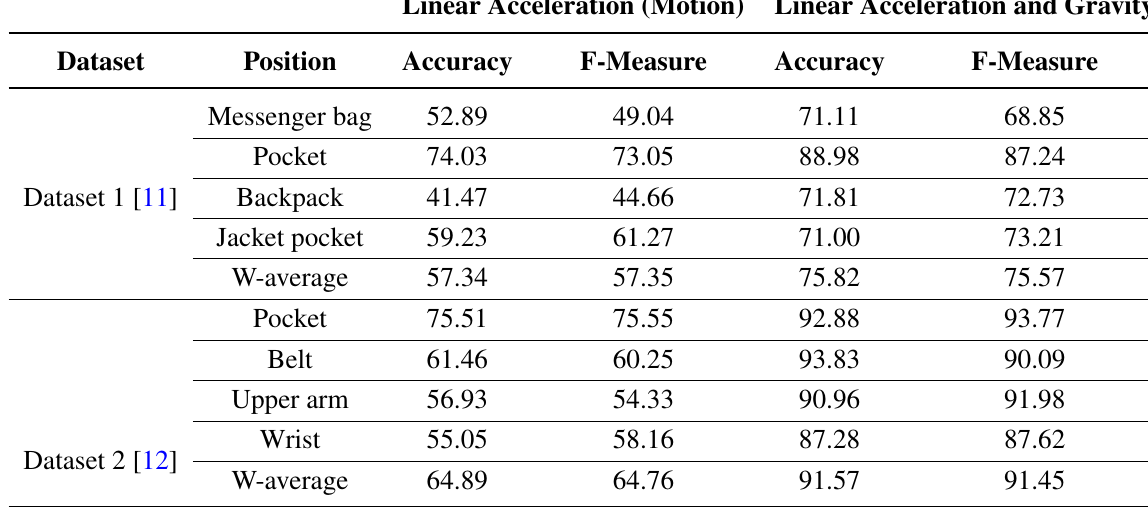
Table 6. Results with linear acceleration and gravity